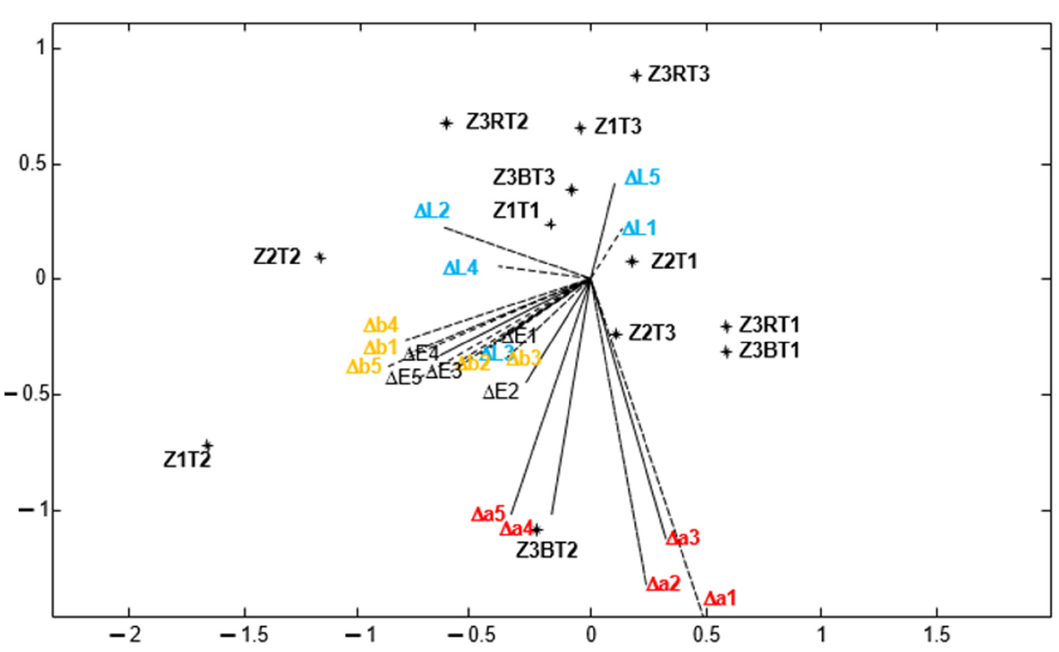
Figure 4. MANOVA-Biplot representation of the different Zamora building stones studied on the plane 1–4.